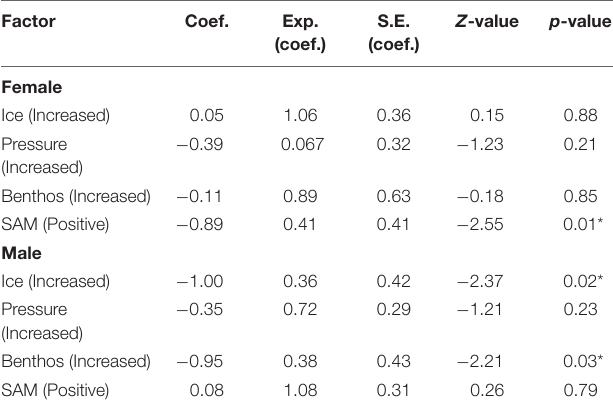
TABLE 2 | The influence of behavioural choices and environmental variables on tag failure rates. Factor